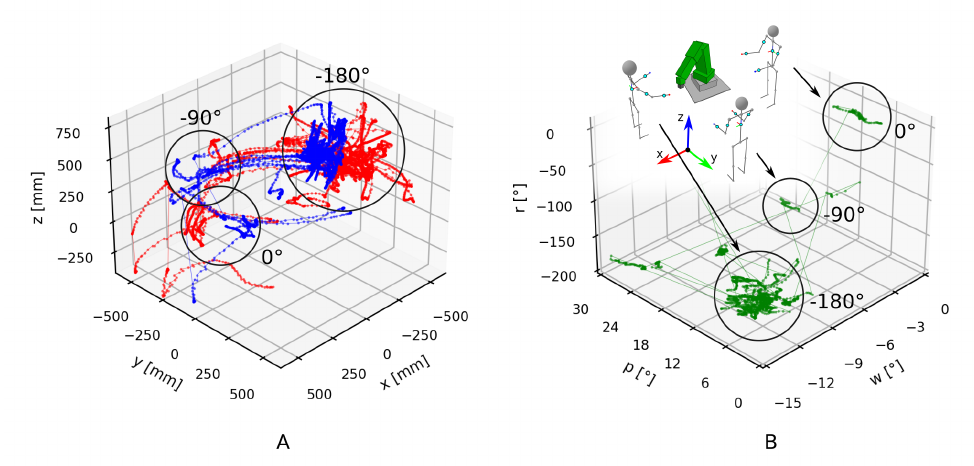
Figure 8. ( A ) Translation of the operator’s left (blue) and right (red) hands, and ( B ) rotation of the operator’s body while performing the evaluation task with the developed IMU system.